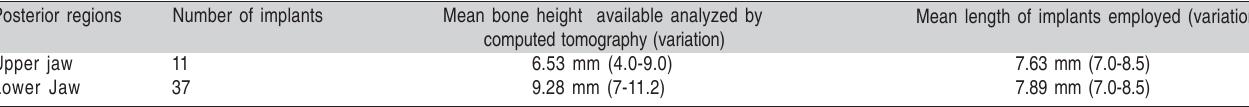
Table 4. Percentage of success of loaded Time interval in months of load (longitudinal evaluation)